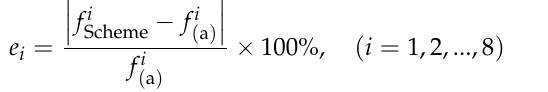
Figure 5. The first four mode shapes of the beam. ( a ) 1st mode in x-direction ( f mode in y-direction ( f = 56.62 Hz); ( c ) 2nd mode in x-direction ( f 2 y-direction ( f = 146.16 4